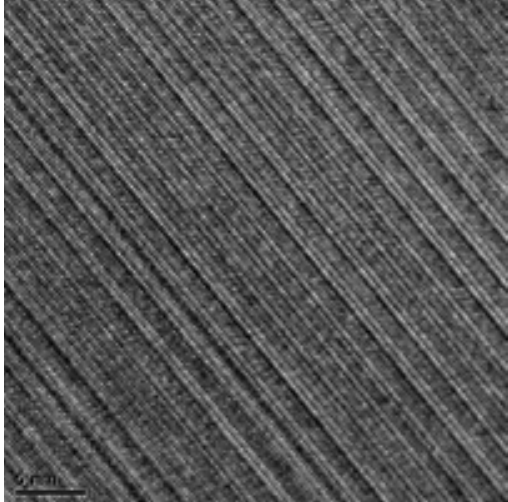
Zn Y matrix and lamellar 98.5 0.5 1